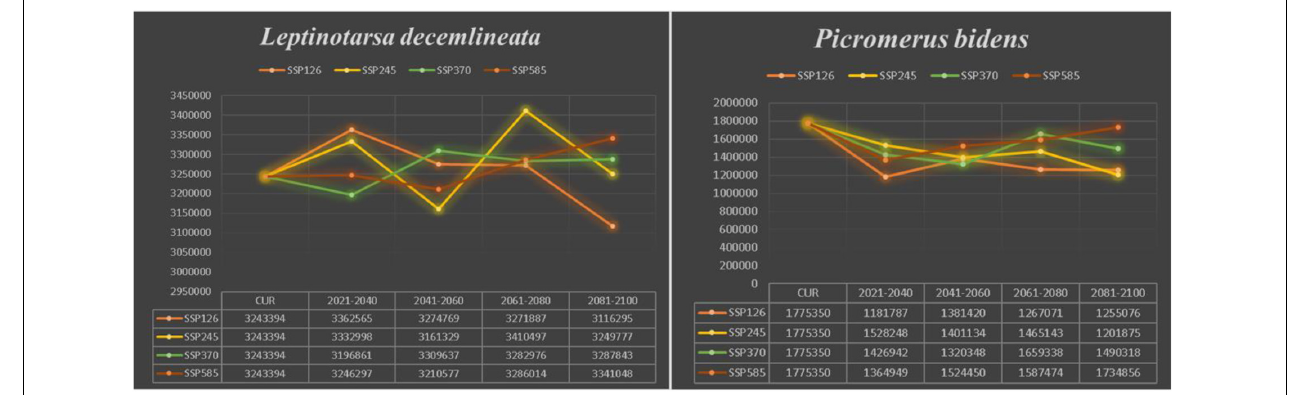
FIGURE 6 | The trend of change in the suitable distribution area of CPB and P. bidens under future climate